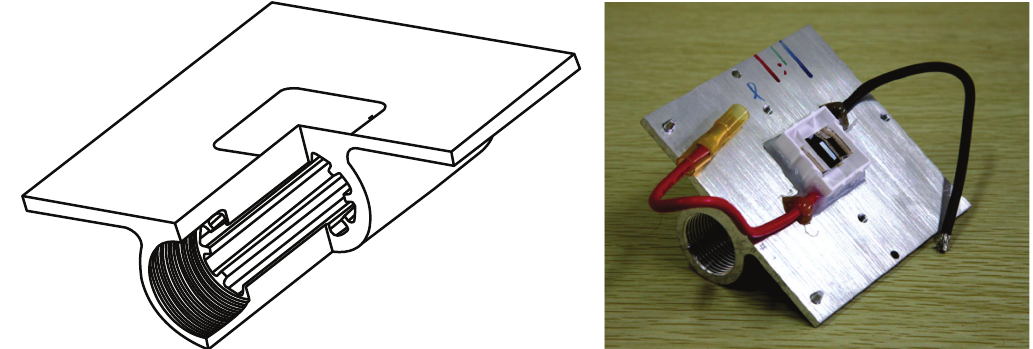
Figure 3: Schematic and photograph of a CPV/T component with grooved tube.